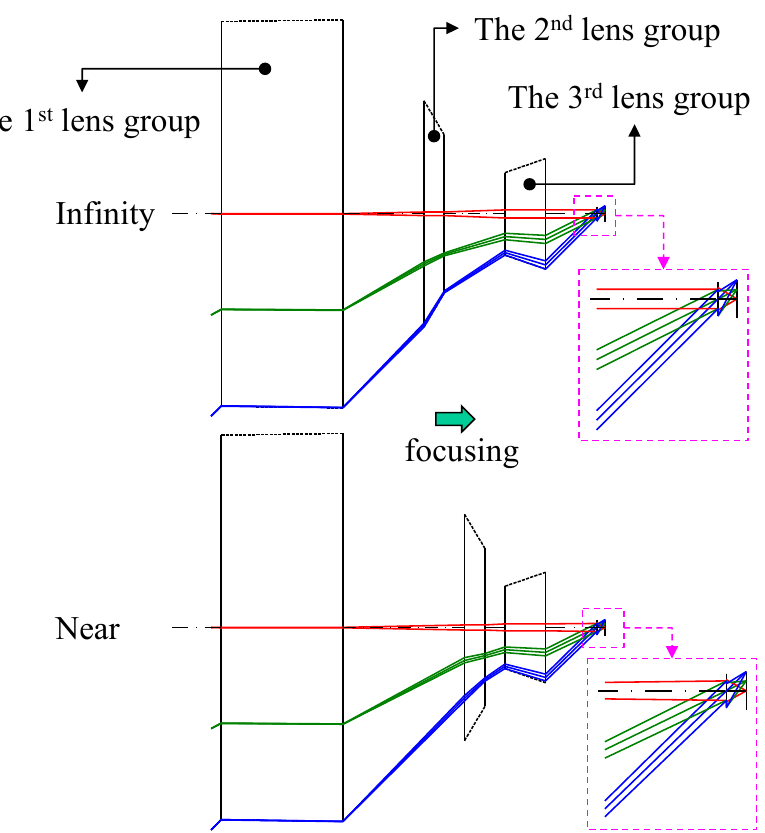
Figure 4. Result of the paraxial power arrangement of the focus-adjustable collimator system.